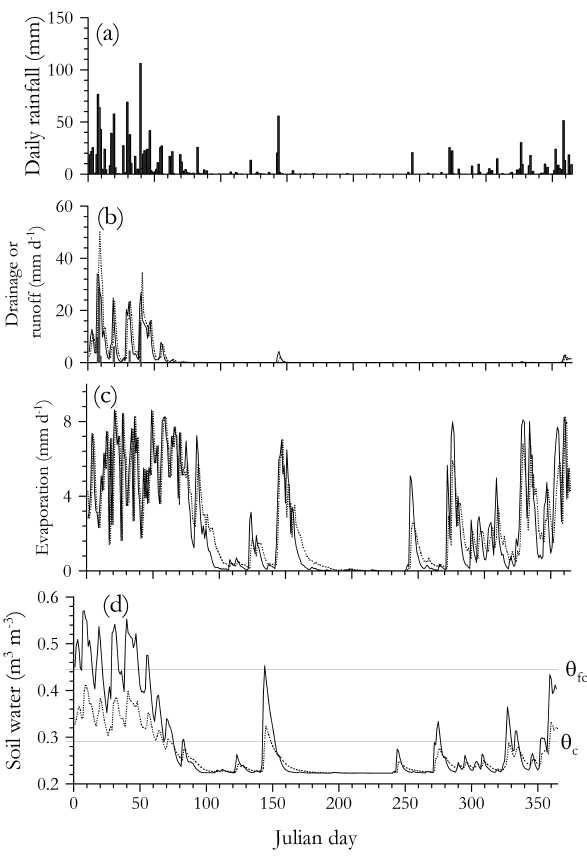
Figure B3. Simulated soil water budget components as affected by the presence of an impermeable layer at KEN-01. (a) Precipitation, (b) drainage and runoff, (c) ecosystem transpiration and (d) soil wa- ter content. Solid lines: impermeable layer at 0.3m depth. Dashed lines: with the same annual evaporation; but with no barrier to ver- tical water flow (rooting depth of 0.7m). Red bar in (b) shows sim- ulated daily runoff totals (impermeable layer only). Also shown in (d) are the prescribed minimum (critical) soil water content for plant water uptake ( θ c ) and field capacity ( θ c